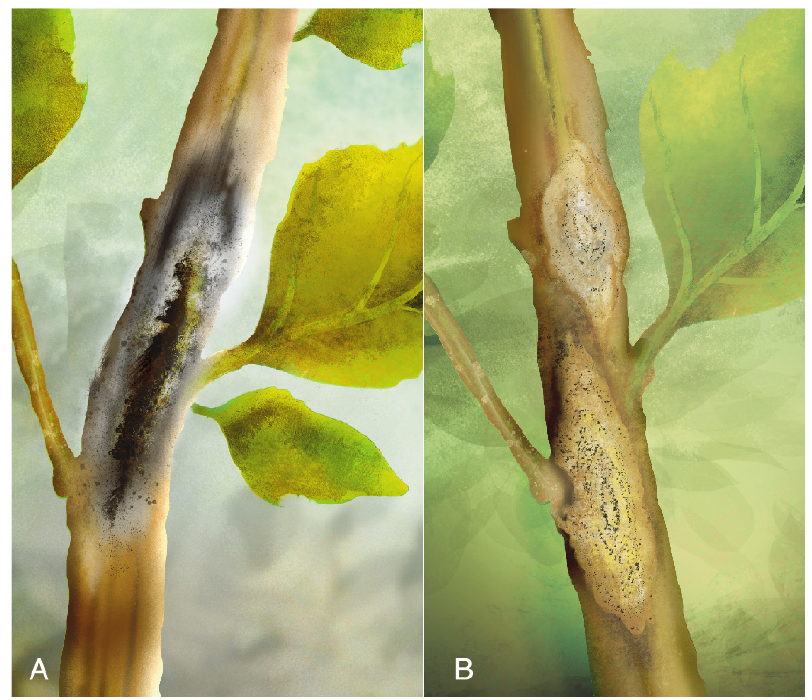
Figure 17. ( A ) Brown stalk rot. ( B ) Diamond-shaped symptoms bearing pycnidia. Source: illustra- tions adapted from Alandia et al.